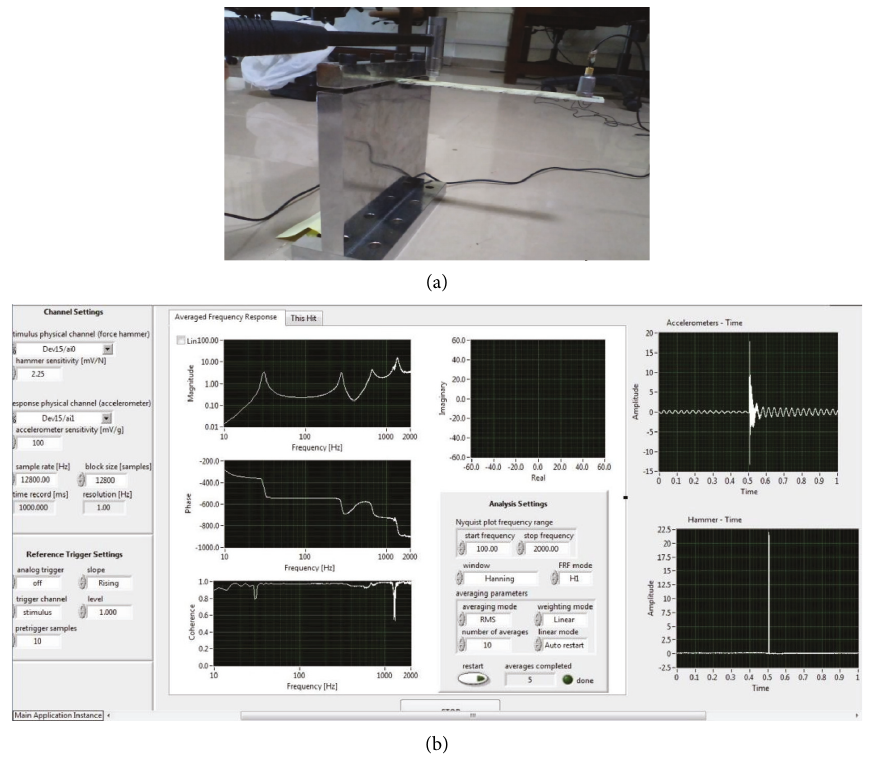
Figure 5: (a) FFT analyzer setup with an accelerometer (YMC121A100 IEPE). (b) Pulse software.